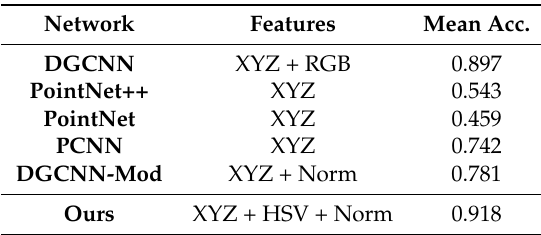
Figure 4. 6-Fold Cross Validation on the TR_church scene. The white fold in every experiment is the scene part used for the test. Table 2. 6-Fold Cross-Validation on the Trompone scene. We can see different combinations of hyperparameters for the various state-of-the-art